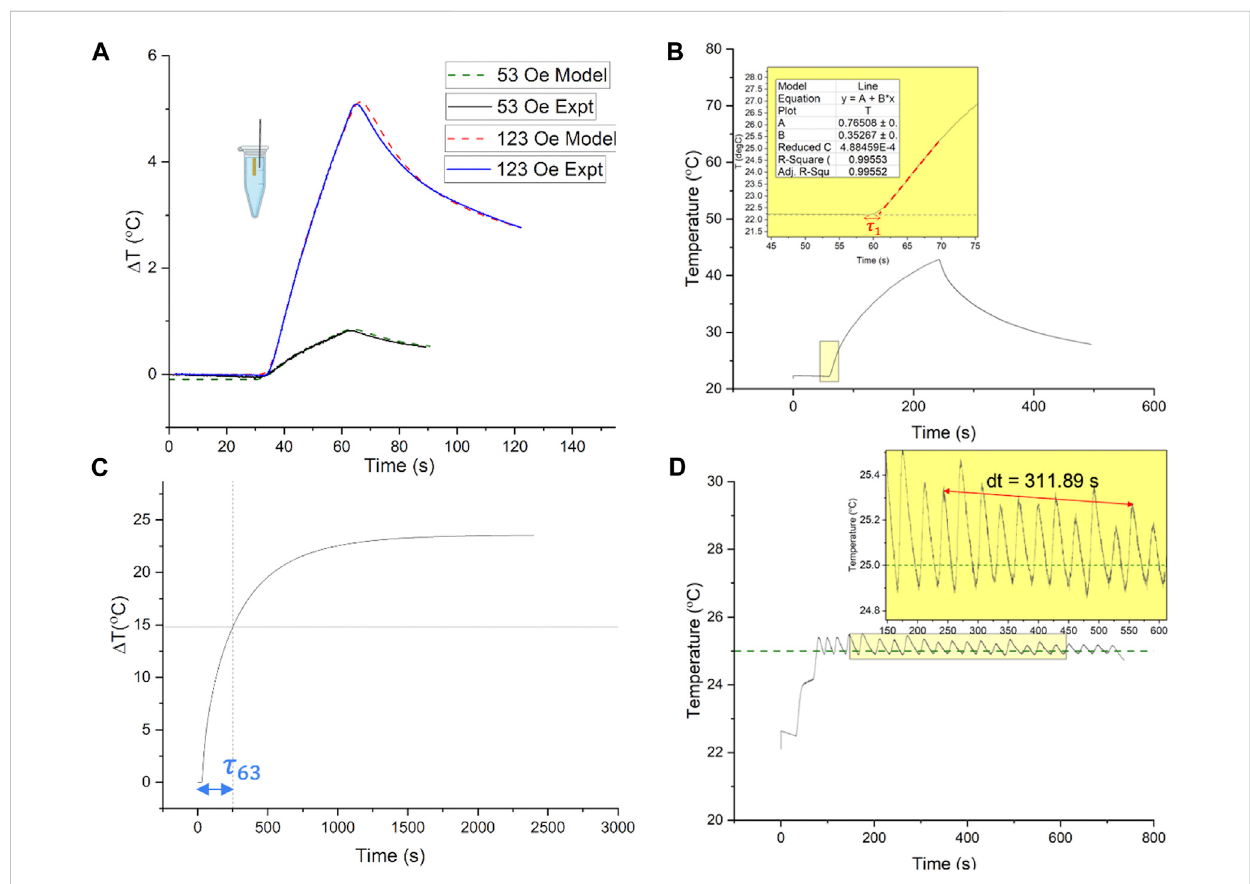
FIGURE 2 (A) Experimental validation ofsimulatedopen looptemperaturechangevs. timeresponsesintheagarosegel+Cu wiresystem, toa30 sAMFpulse. The responses were tested to 30 s AMF pulses of amplitude 4.2 kA/m and 9.8 kA/m peak fi eld (160 kHz), respectively, which de fi ne the limits of the AMF fi eld range used in PID control (4.2 – 9.8 kA/m peak, 160 kHz). Solid lines indicate experimentally measured temperature vs. time curves during heating (AMF ON) and cooling (AMF OFF) at 53 Oe (4.2 kA/m, lower curve) and 123 Oe (9.8 kA/m, upper curve). Dashed lines are obtained from the fi nite elementanalysis(FEA)agarosegel+Cuwiremodel,withthelowerdashedcurvecorrespondingtoAMFamplitudeof53 Oe(4.2 kA/m)andupperdashed curvecorrespondingto AMFamplitude of123 Oe(9.8 kA/m). (B,C) Estimationofheatingtime constants, fromopen looptemperaturevs.timeresponses of the agarose gel + Cu wire system, for evaluation of PID gains for feedback control. (D) Closed loop temperature vs. time response of gel + Cu wire system with proportional gain, used to evaluate the undamped natural frequency of the system, ω n ~ 0 . 2 rad / s